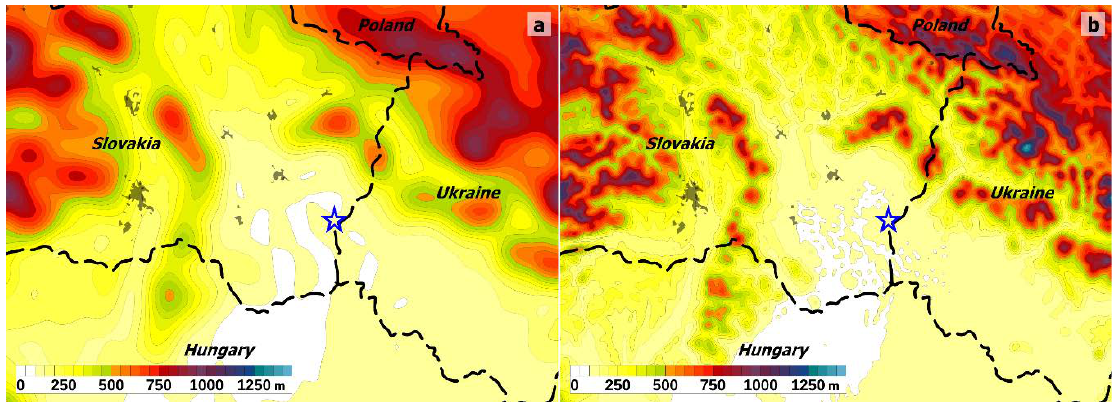
Figure 14. Model topography of NWP ( a ) OPM with grid spacing of 4.5 km and ( b ) ELAM with grid spacing of 1 km. Country names shown in italics; tornado location highlighted by blue star.